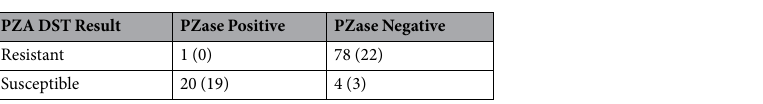
Table 2. Results of the Wayne ’ s pyrazinamidase (PZase) activity assay for 103 (including 44 pncA genotypic- phenotypic discordant) clinical M. tuberculosis isolates. Drug susceptibility was determined by BACTEC MGIT 960. Numbers in parentheses indicate the number of isolates with discordant PZA phenotype and pncA genotypic (i.e. resistant isolates with WT pncA and promoter or susceptible isolates with mutant pncA or promoter).